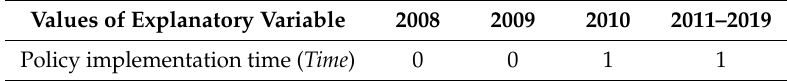
Table 2. Values of the explanatory variable Time .